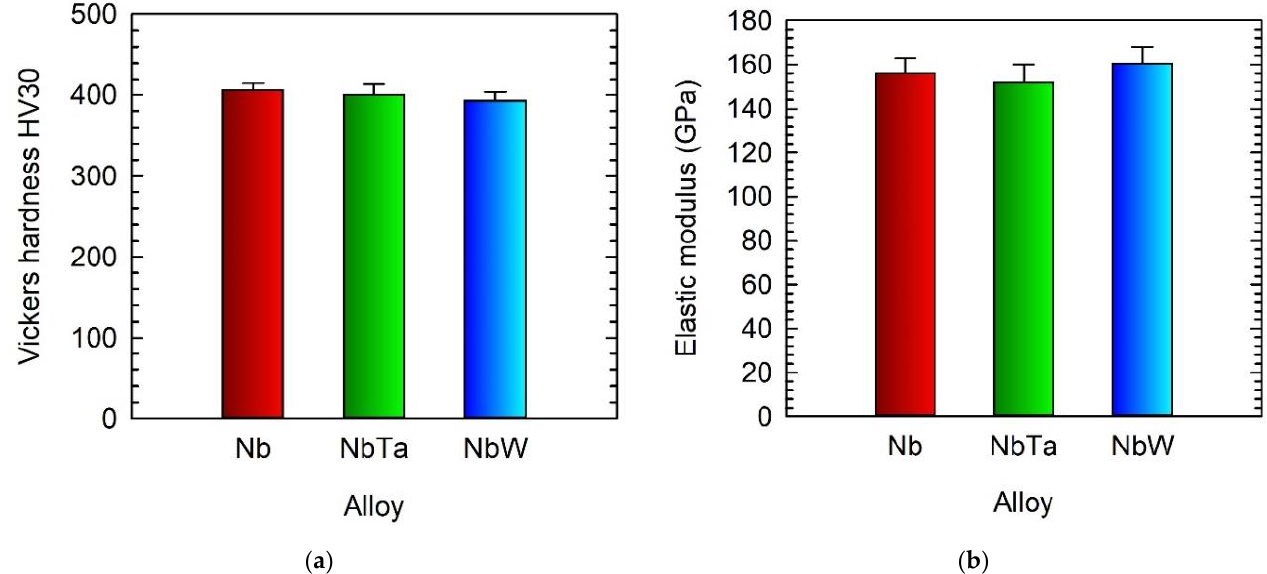
Figure 7. Vickers hardness and elastic modulus of tilt-cast Nb, NbTa, and NbW alloys: ( a ) Vicker hardness HV30, ( b ) indentation elastic modulus. The studied alloys are marked in the figures.